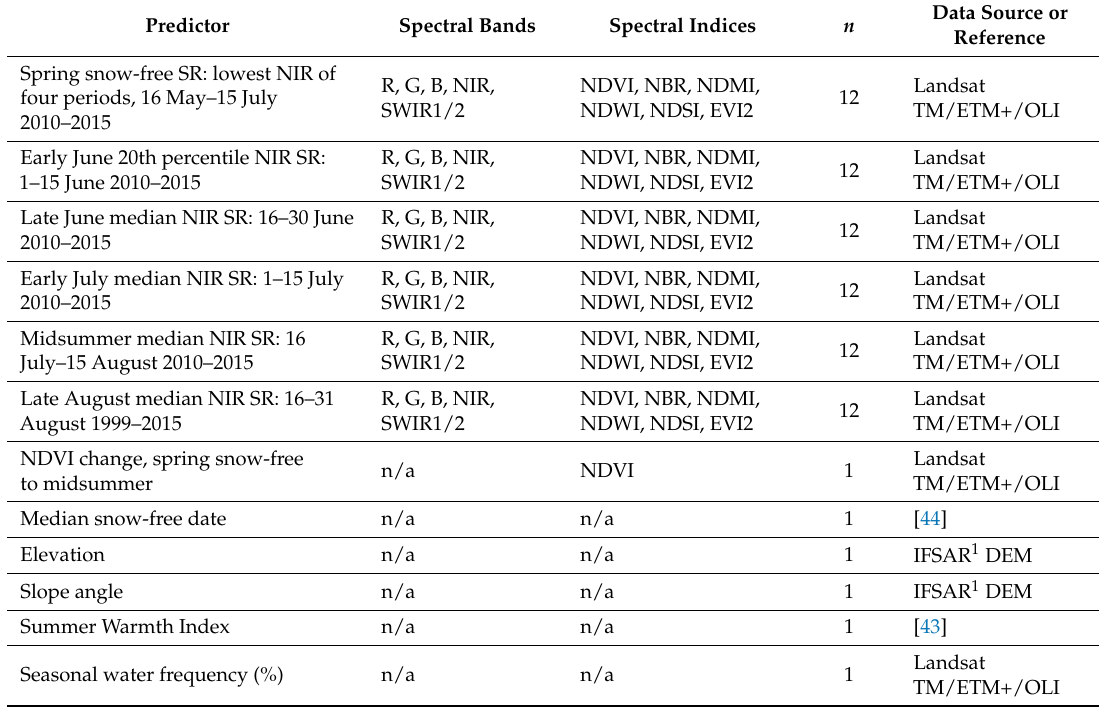
Table 2. Spectral and environmental predictors for random forest models of tundra PFTs and other cover types, North Slope, Alaska. SR is surface